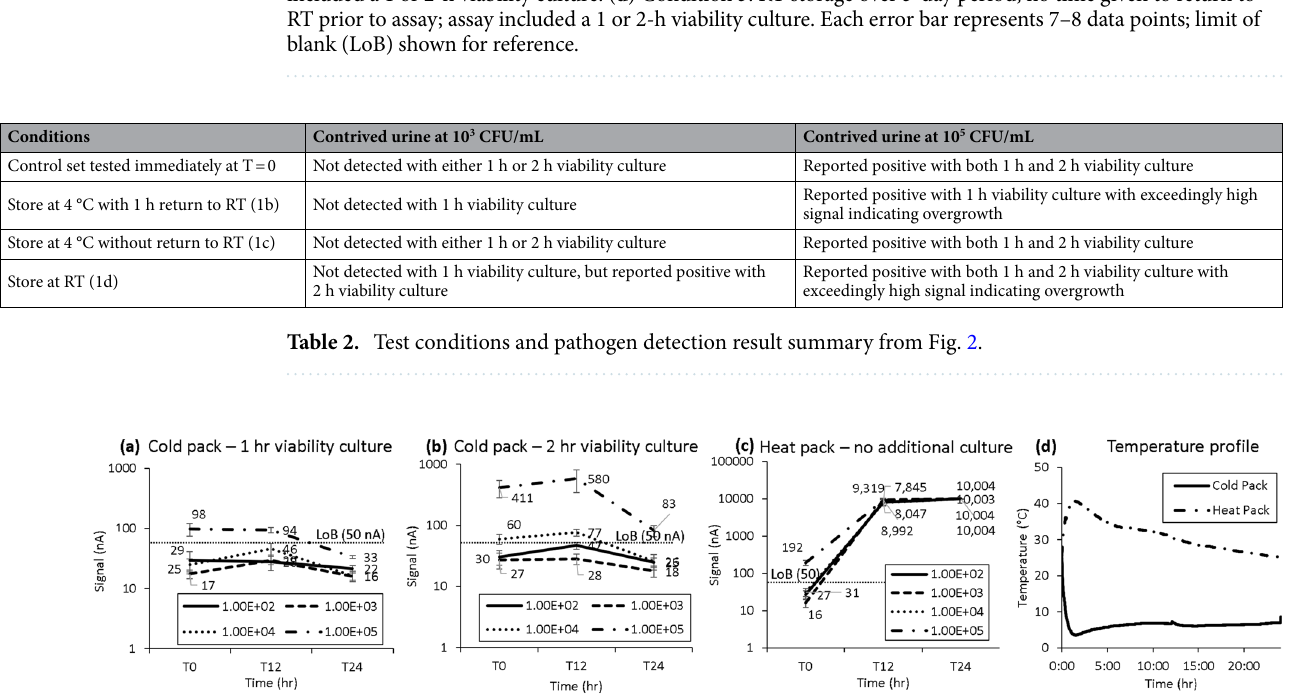
Figure 2. ( a ) Day 0 and ( b – d ) Day 3 viable pathogen detection assay results for contrived E. coli urine samples, comparing different storage and assay conditions. All samples were stored in C&S tubes. ( b ) Condition 1: 4 °C storage over 3-day period; given 1 h to return to RT prior to assay start time; assay included a 1-h viability culture. ( c ) Condition 2: 4 °C storage over 3-day period, no time given to return to RT prior to assay; assay